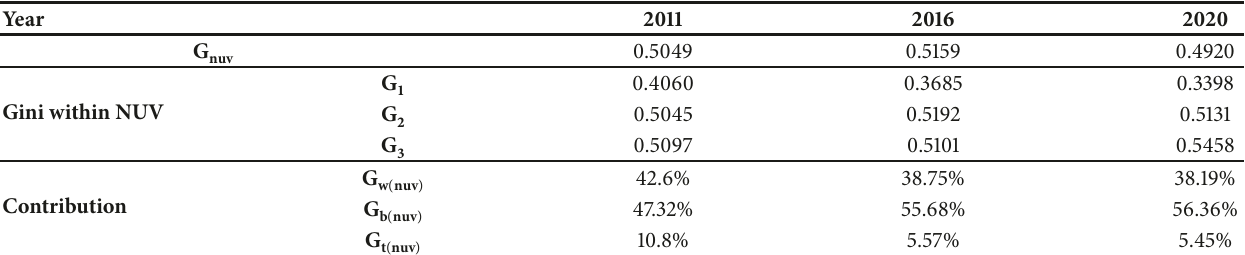
Table 6: Decomposition of the Gini coefficient of NUV between subgroups.